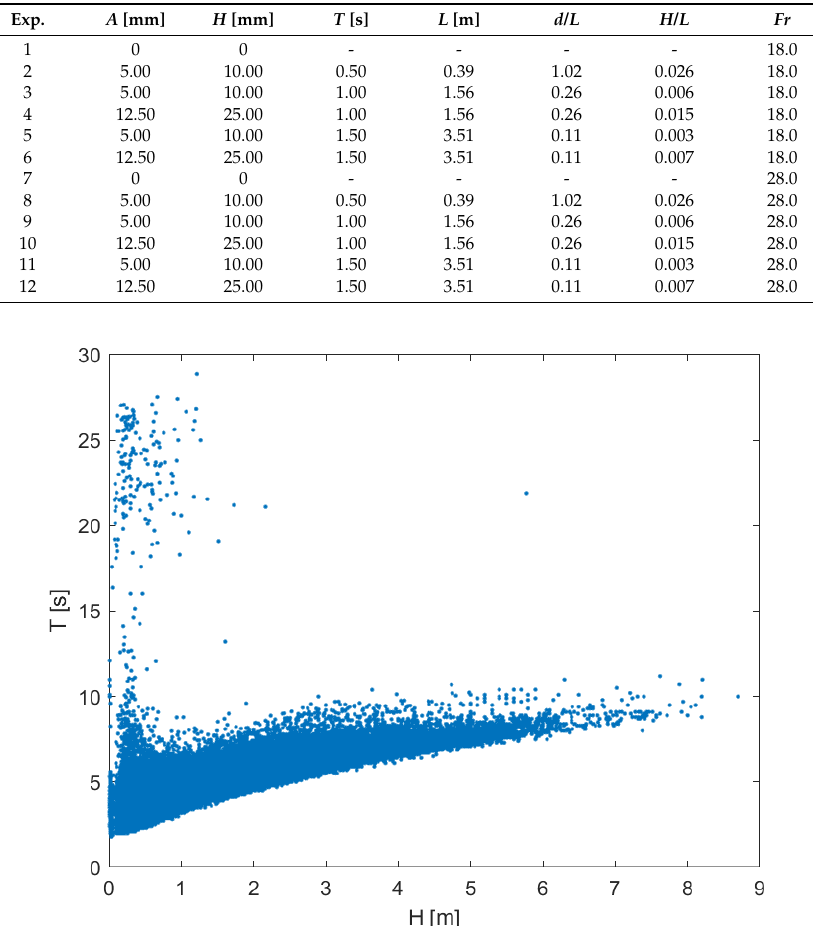
Figure 1. Wave period T versus wave height H recorded by the Alghero wave buoy in the period 2002–2014; data from the Rete Ondametrica Nazionale (Italian National wavemetric System)